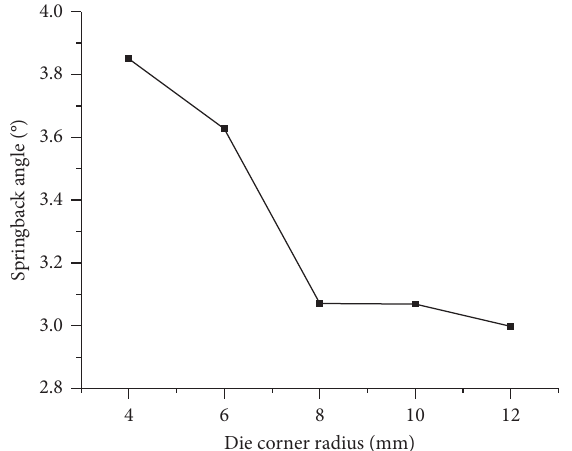
Figure 20: Curves of equivalent plastic strain after springback.